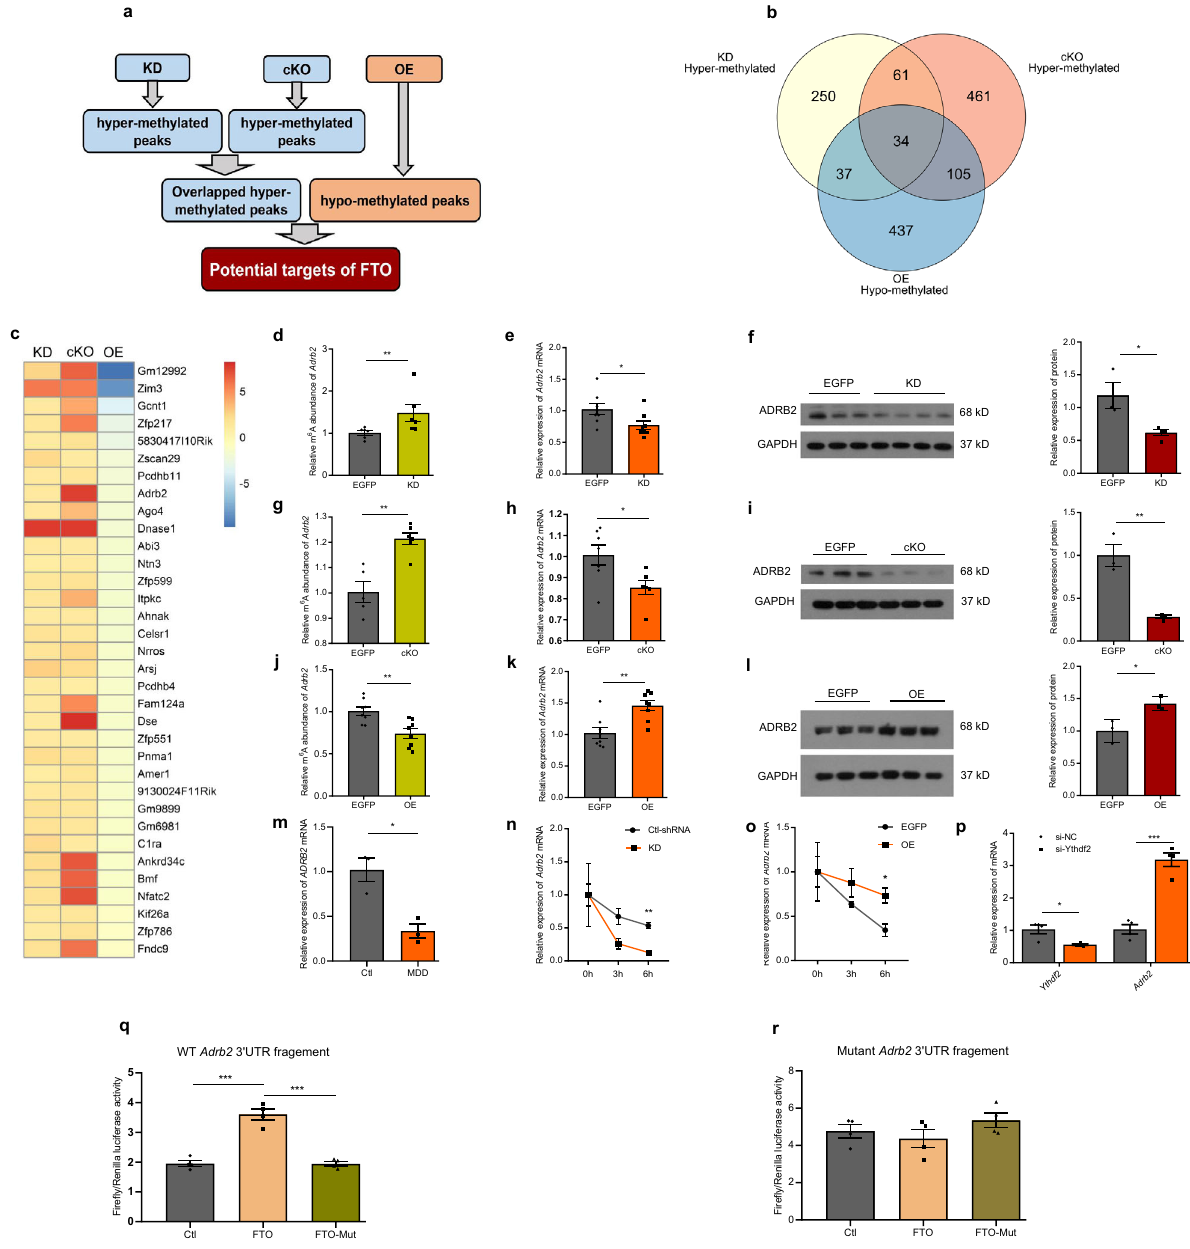
Fig. 4 ADRB2 is one of the critical target genes of FTO in the hippocampus. a Schematics of the strategy used to identify the targets. b Overlap of the genes that are hypermethylated in KD and cKO mice and hypomethylated in OE mice. c Thirty-four genes that are hypermethylated in KD and cKO mice and hypomethylated in OE mice. d – l m 6 A, mRNA, and protein levels of Adrb2 in the hippocampus of KD ( d – f ) cKO ( g – i ) and OE ( j – l ) mice. d n = 6 per group, p = 0.0087; e n = 8 per group, p = 0.0381; f EGFP, n = 3; KD, n = 4, p = 0.0243; g EGFP, n = 5; cKO, n = 6, p = 0.0012; h EGFP, n = 7; cKO, n = 6, p = 0.0269; i n = 3 per group, p = 0.0053; j n = 8 per group, p = 0.0032 k n = 8 per group, p = 0.0022; l n = 3 per group, p = 0.0232. The detection of ADRB2 in panel l was in the same experiment as the detection of SIRT1 in OE in panel e of Fig. 5. m Expression of Adrb2 mRNA in the hippocampus of MDD patients and healthy controls. n = 3 per group, p = 0.0115. n , o Adrb2 mRNA stability assay after transfection of Neuro-2a cells with plasmids expressing Fto -shRNA or Fto . n = 4 per time point. n Ctl-shRNA vs. KD, 6 h, p = 0.0053; o EGFP vs. OE, 6 h, p = 0.0383. p Levels of Ythdf2 and Adrb2 mRNA after knockdown of Ythdf2 in Neuro-2a cells. n = 4 per group. Ythdf2 , p = 0.0130003; Adrb2 , p = 0.000153. q , r Relative luciferase activity of pMIR-GLO- Adrb2 - 3 ′ UTR, with either wild-type (WT Adrb2 3' UTR fragement) or mutant m 6 A sites (Mutant Adrb2 3' UTR fragement) after co-transfection with control vector (Ctl), FTO (FTO), or FTO-mutant (FTO-Mut) into HEK293T cells for 48 h. Fire fl y luciferase activity was measured and normalized to Renilla luciferase activity, n = 4 per group. q Ctl vs. FTO, p = 0.0002; FTO vs. FTO-Mut, p = 0.0002 r Ctl vs. FTO, p = 0.5376; FTO vs. FTO-Mut, p = 0.1666. * p < 0.05, ** p < 0.01, *** p < 0.001. Two-tailed Student ’ s t -test for d – m & p ; two-way ANOVA with repeated measures followed by post hoc Tukey ’ s test